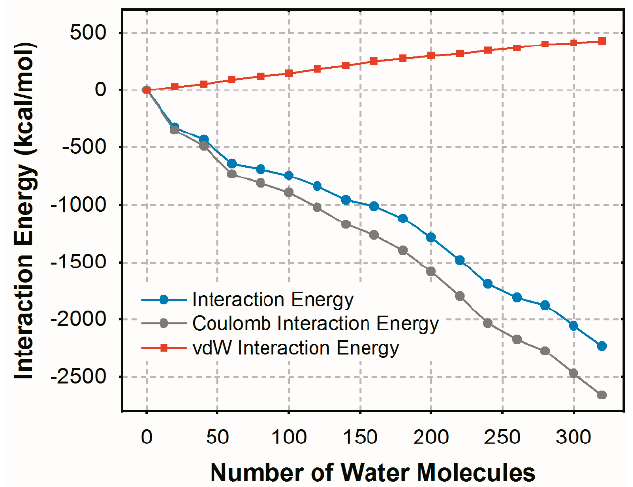
Figure 5. Evolution of clay-water interaction energy (blue) and the decomposed Coulomb interaction energy (gray) and Van der Waals interaction energy (red) with increasing water content for MLC with 50% Na + and 50% K + .